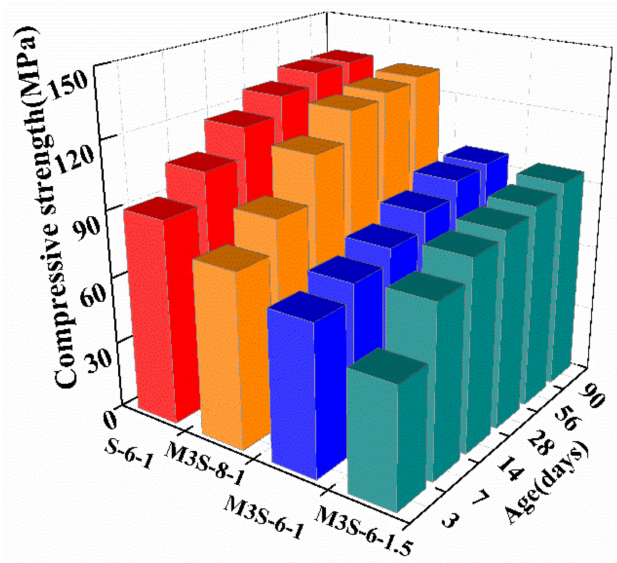
Figure 7. Effects of activator concentration and activator on the compressive strength of alkali-activated slag mortar with 30%